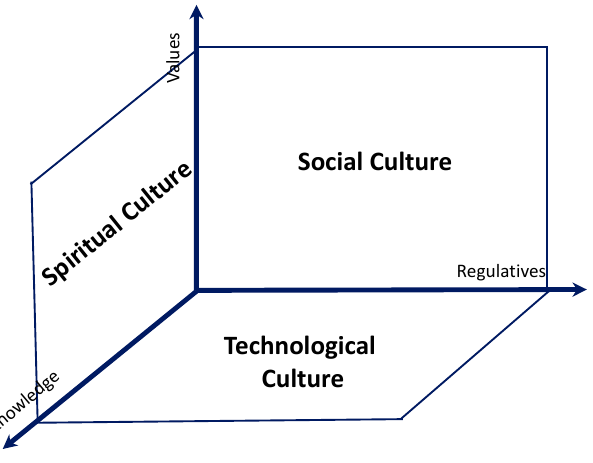
Figure 1. Cultural space.